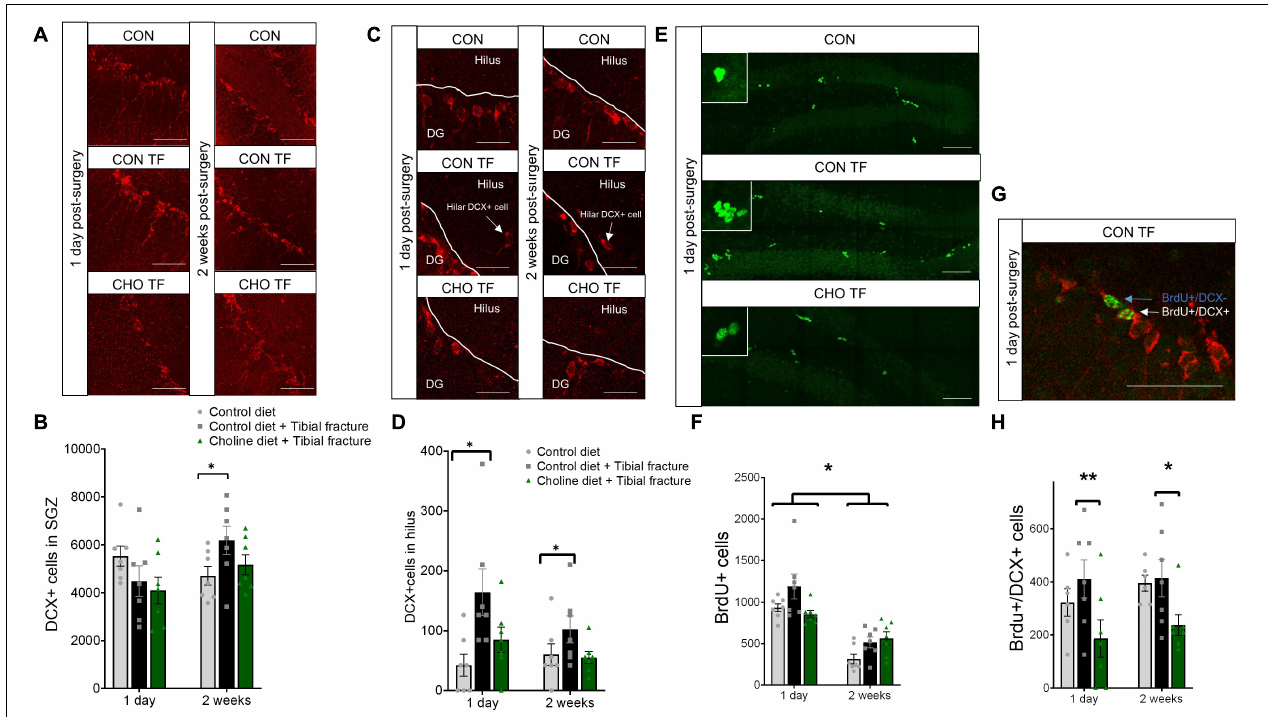
FIGURE 4 | (A) Representative fluorescent micrographs of the SGZ taken 1 day and 2 weeks after surgery, immunostained with doublecortin (DCX), presented as maximum intensity projections of the Z-stack. CON, control diet + naïve; CON TF, control diet + tibial fracture surgery; CHO TF, choline diet + tibial fracture surgery. Scale bar: 50 µ m. (B) Histogram showing the number of DCX+ cells in the subgranular zone (SGZ) of the dentate gyrus. N = 7 per group. * p < 0.05, Tukey HSD. Each bar represents the mean ± SEM. (C) Representative fluorescent micrographs of the SGZ taken 1 day and 2 weeks after surgery, immunostained with DCX, presented as a single image plane in the Z-stack. Scale bar: 25 µ m. CON, control diet + naïve; CON TF, control diet + tibial fracture surgery; CHO TF, choline diet + tibial fracture surgery. (D) Histogram showing the number of DCX+ cells in the hilus of the dentate gyrus. N = 7 per group. * p < 0.05, Tukey HSD. Each bar represents the mean ± SEM. (E) Representative fluorescent micrographs of BrdU+ cells in the SGZ, taken 1 day after surgery. Two-week images not shown. Scale bar: 100 µ m. (F) Histogram showing the number of BrdU+ cells in the SGZ of the dentate gyrus. N = 7 per group. * p < 0.05, Tukey HSD. Each bar represents the mean ± SEM. (G) Representative fluorescent micrograph of a BrdU+/DCX+ cell (white arrow) and a BrdU+/DCX − cell (blue arrow). Scale bar: 50 µ m. (H) Histogram showing the number of BrdU+/DCX+ cells in the SGZ of the dentate gyrus. N = 6–7 per group. * p < 0.05, ** p < 0.01, Tukey HSD. Each bar represents the mean ±